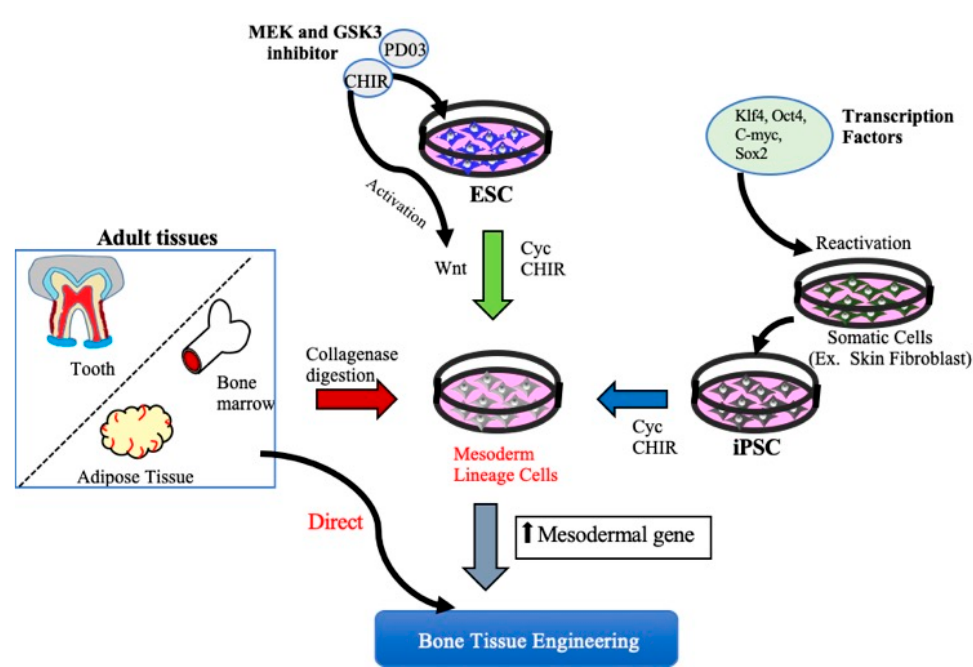
Figure 1. Schematic diagram of different approaches to obtain Mesenchymal stem cells. MSCs can be derived from either iPSCs, ESCs, or adult mesenchymal tissue. MSCs can be obtained by ESCs and iPSCs using small molecules such as mitogen-activated protein kinase (MEK) inhibitor, (MEK) inhibitor, PD0325901, glycogen synthase kinase 3 (GSK3) inhibitor, and CHIR99021 (CHIR). MSCs are also be derived from various connective tissues such as bone marrow, adipose tissue, and dental tissues by collagenase digestion or aspirates from bone marrow and adipose tissue directly used for BTE therapeutics. KLf4: Kruppel Like Factor 4, Oct4: Octamer-binding transcription factor 4, C-myc: